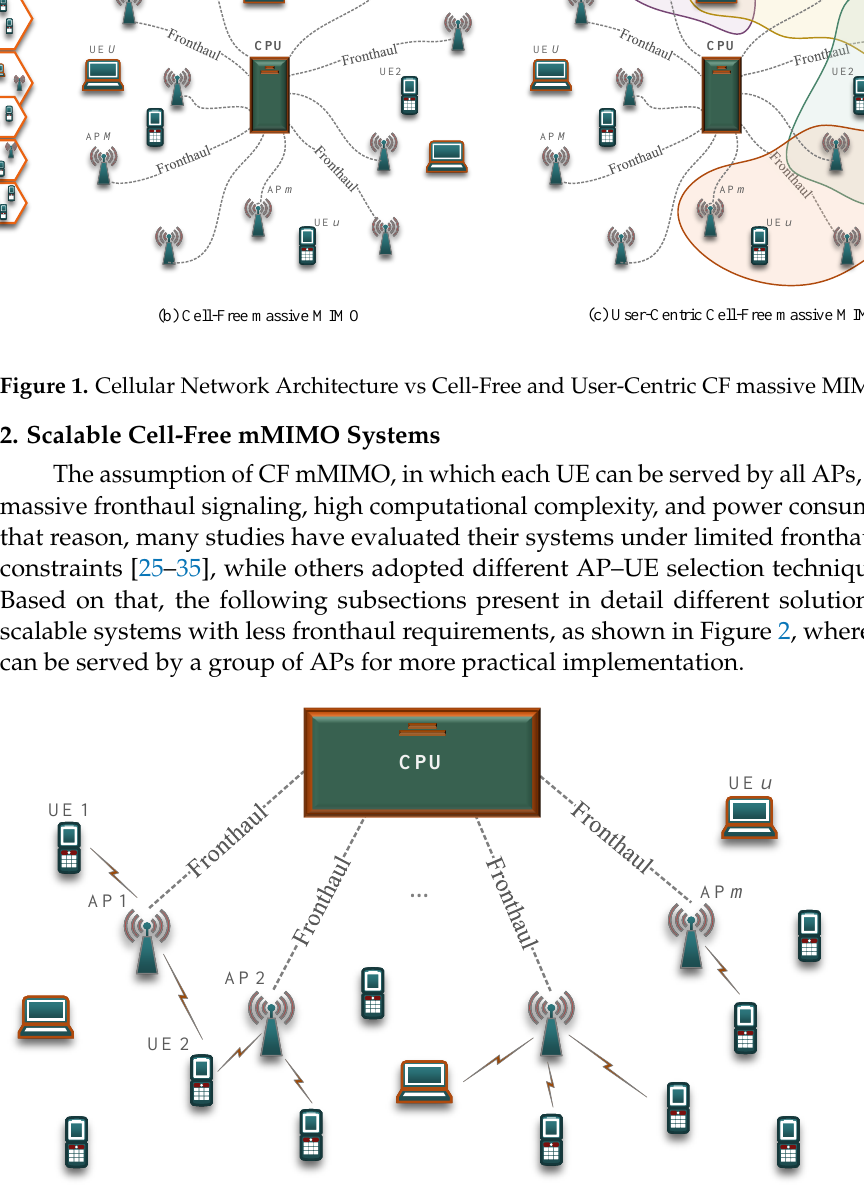
Figure 2. Cell-Free Massive MIMO Systems with Limited Fronthaul